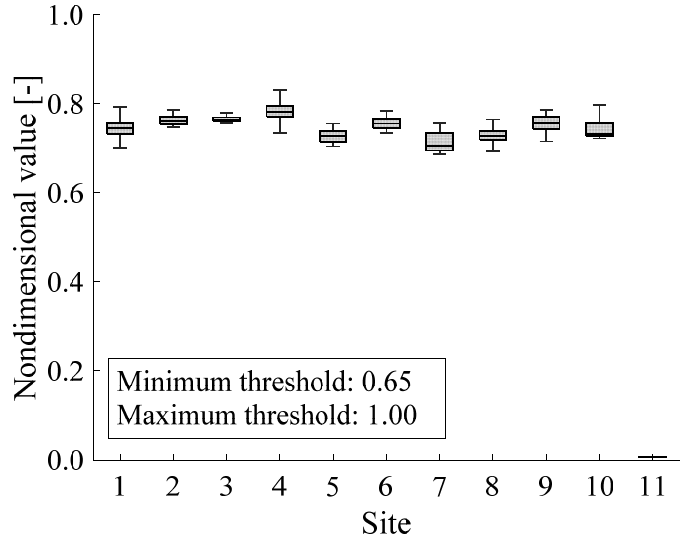
Figure 2. Dataset composition.